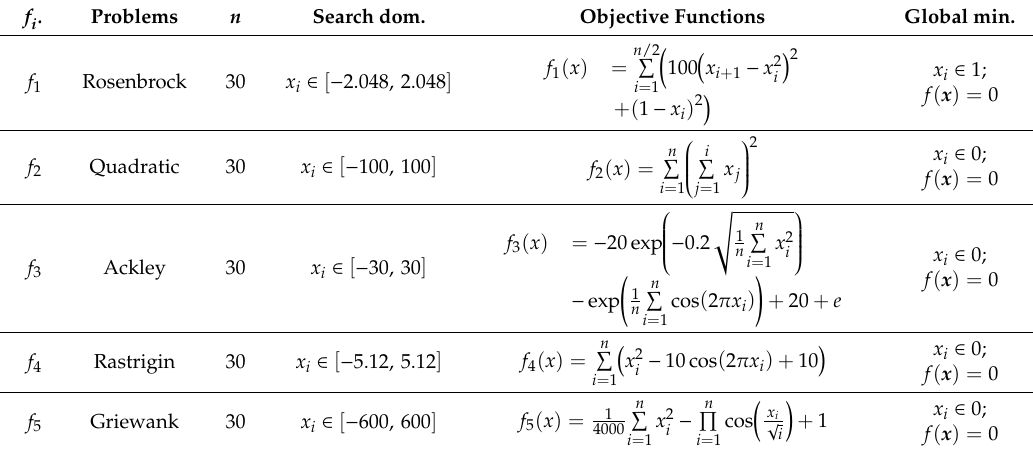
Table 1. The definition of the benchmark